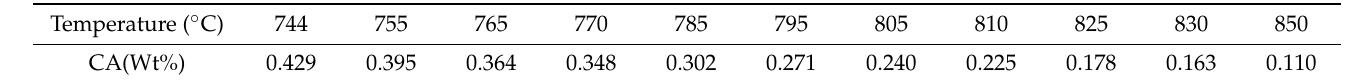
Figure 8. Partial schematic diagram of Fe-C phase diagram. Table 5. Carbon content in austenite at different temperatures in the two-phase